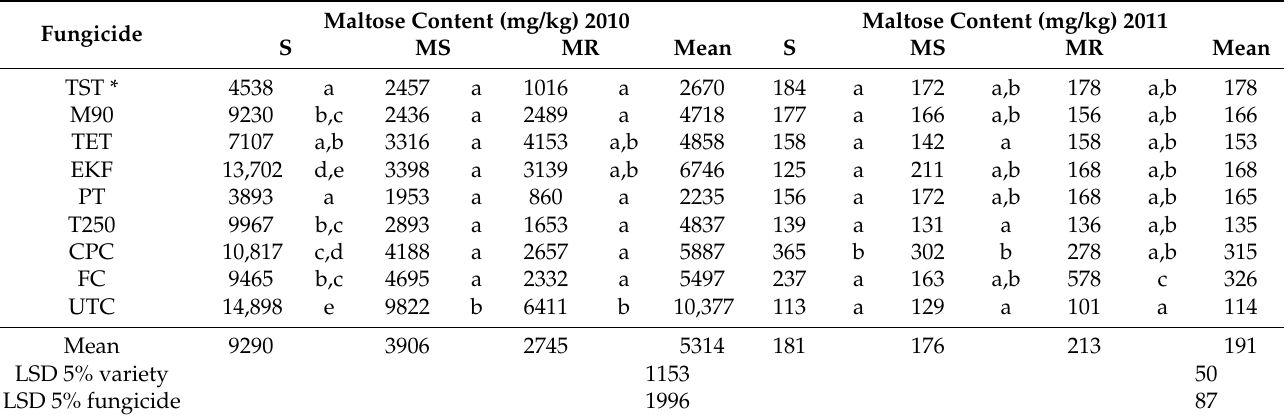
Table 4. Effect of fungicide treatments on maltose content in three wheat varieties, with differing